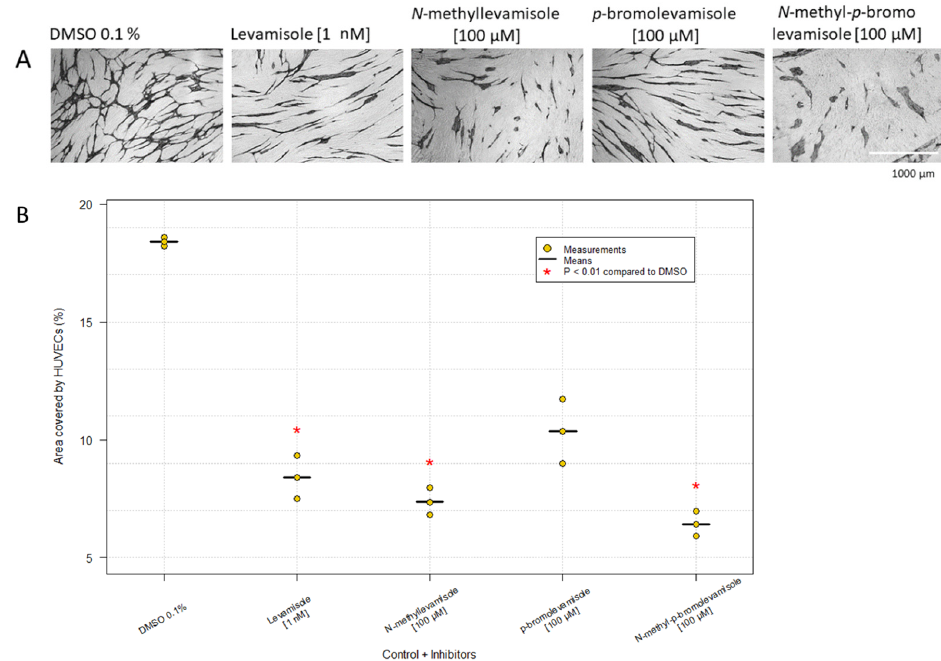
Figure 3. Effect of levamisole and derivatives. ( A ) HUVECs were treated with levamisole, N -methyllevamisole, p -bromolevamisole and N -methyl- p -bromolevamisole. HUVEC morphology was visualized by immunostaining with CD31 MAb. The images are based on one experiment, which is representative of three experiments, with duplicates (magnification: 4×). ( B ) Data are illustrated in the plot as the mean of three independent experiments with duplicates. Kruskal–Wallis Χ 2 = 12.63. P = 0.013. p -bromolevamisole [100 µM] treatment did not differ from the control (adjusted p -value = 0.13).